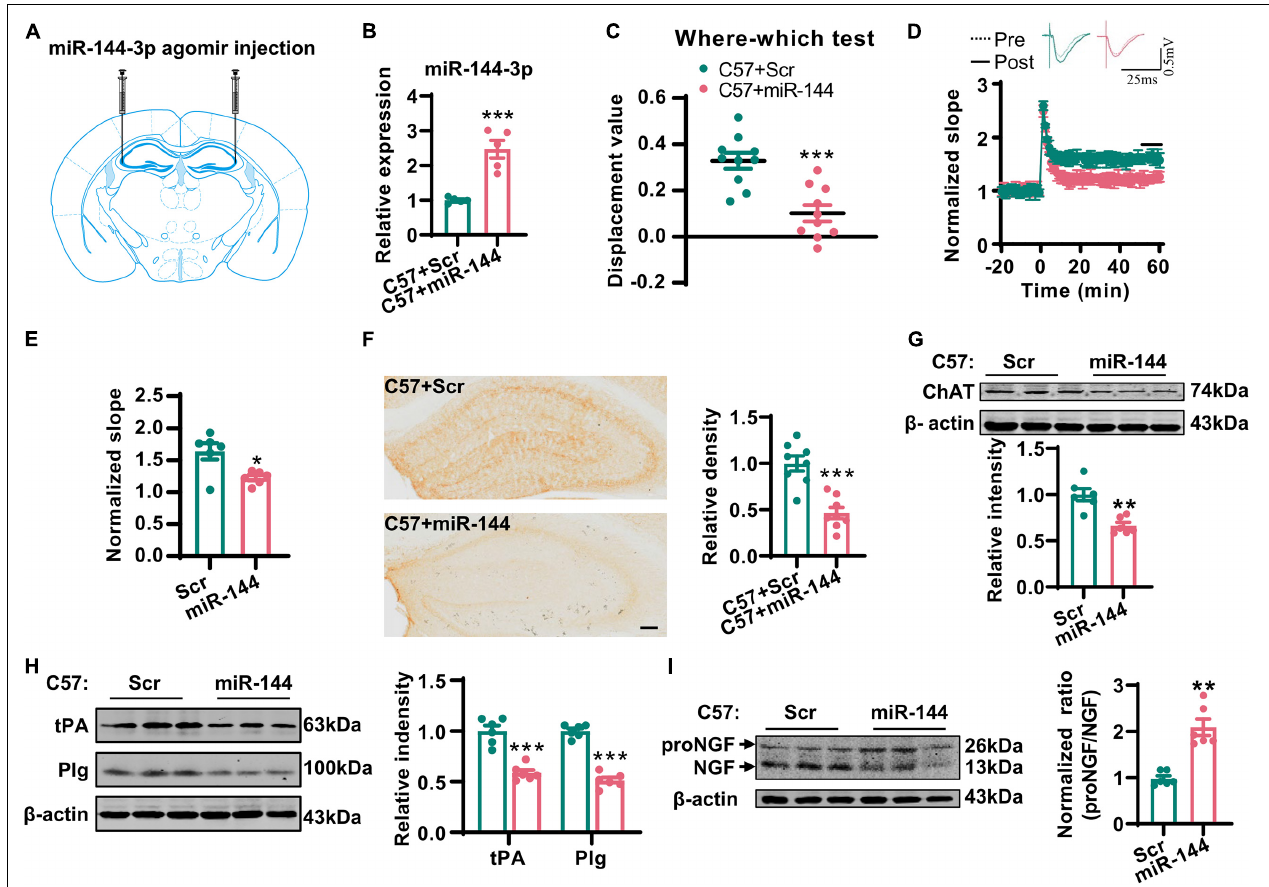
FIGURE 5 | Overexpression of miR-144-3p induced cholinergic degeneration and synaptic/memory impairments. (A) The diagram for the stereotactic injection experiment was shown. (B) The expression of miR-144-3p was evaluated in 3-months-old C57 mice after injection of miR-144-3p agomir 2 weeks later. Unpaired Student’s t -test, n = 5 mice for each group, ** p < 0.01. (C) The where–which test was used to assess the context memory after administration of miR-144-3p agomir. Unpaired Student’s t -test, n = 10 mice for each group, *** p < 0.001. (D) The electrophysiological recording to detect the fEPSP slope was used to